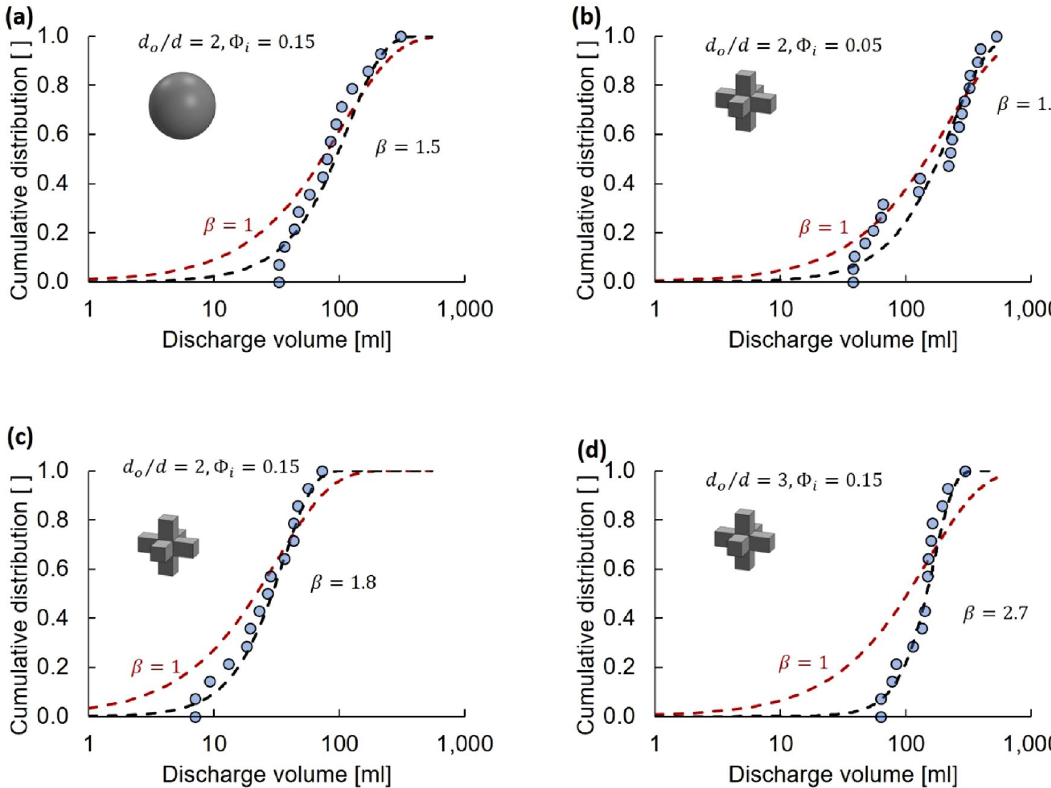
Figure 8. Discharge volume: statistical analysis (experimental results). Cumulative distribution of the discharge volume before clogging V d for ( a ) spheres and ( b – d ) 3D crosses at different initial suspension solidity Φ i and size ratios d o / d . Datapoints: experimental cumulative distribution based on 14 or more experiments. Red dashed line: exponential distribution function ( β = 1). Black dashed line: Weibull distribution function (Eq. 7). β : Weibull shape